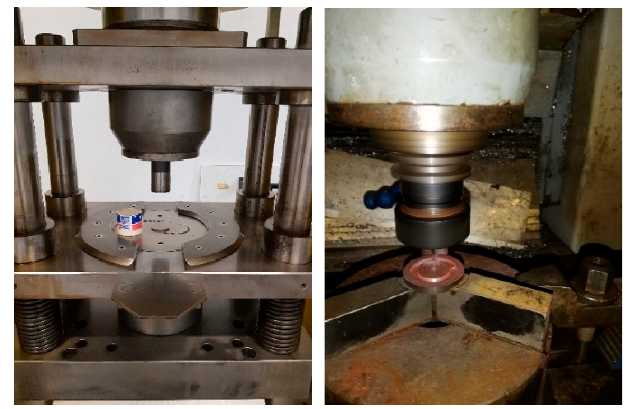
Figure 4. The manufacturing process of the toroid: compacting and milling.